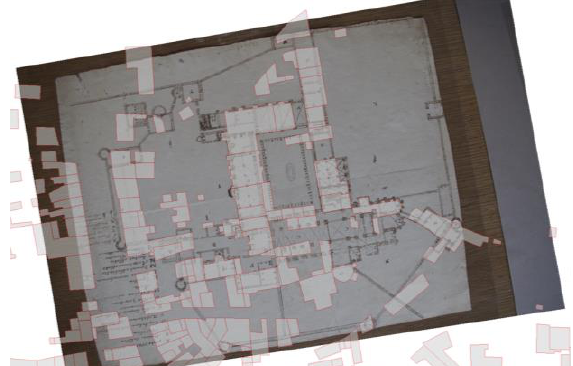
Figure 4. Map of the abbey of Cormery produced in 1674